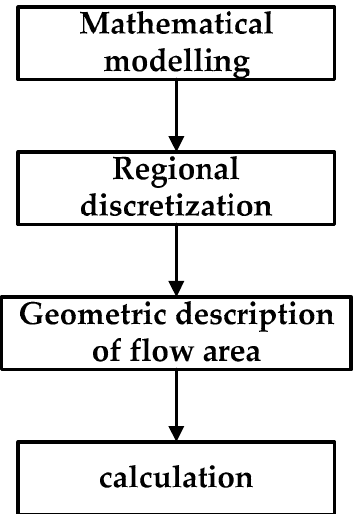
Figure 4. Computational fluid dynamics (CFD) mesh generation and numerical solution process.